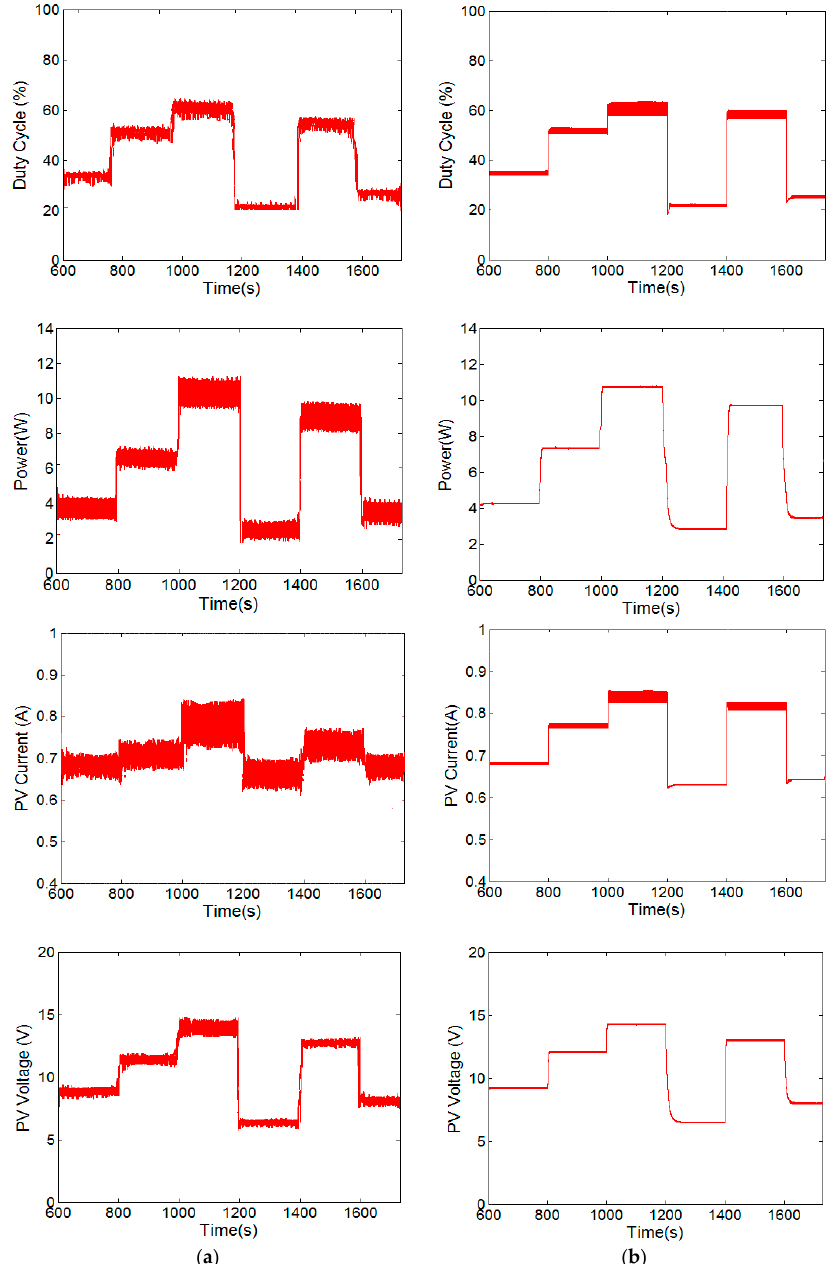
Figure 10. ( a ) Experimental and ( b ) simulated MPPT duty cycle, power, current voltage with P&O.